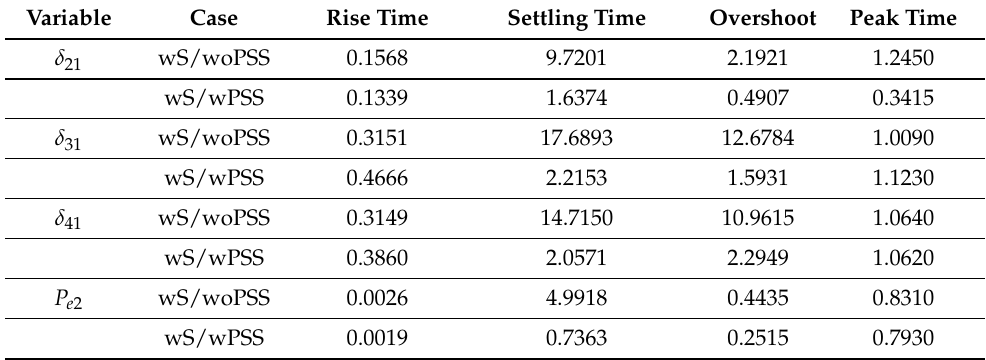
Table 6. Analysis in time domain of the responses for case 2.